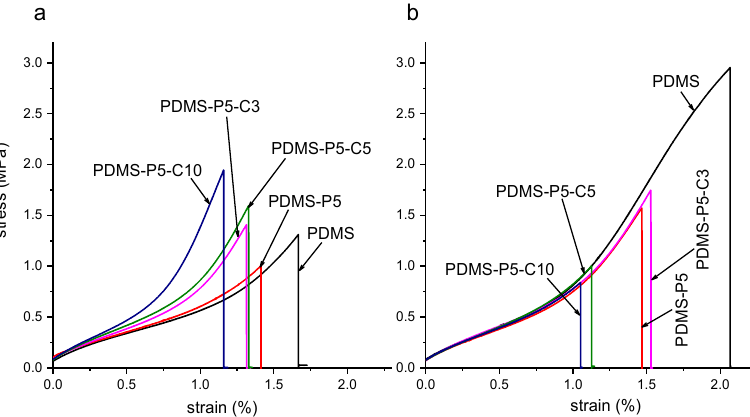
Figure 7. Representative tensile stress–strain curves obtained on the prepared film samples: ( a ) room temperature (23 °C); ( b ) 60 °C.